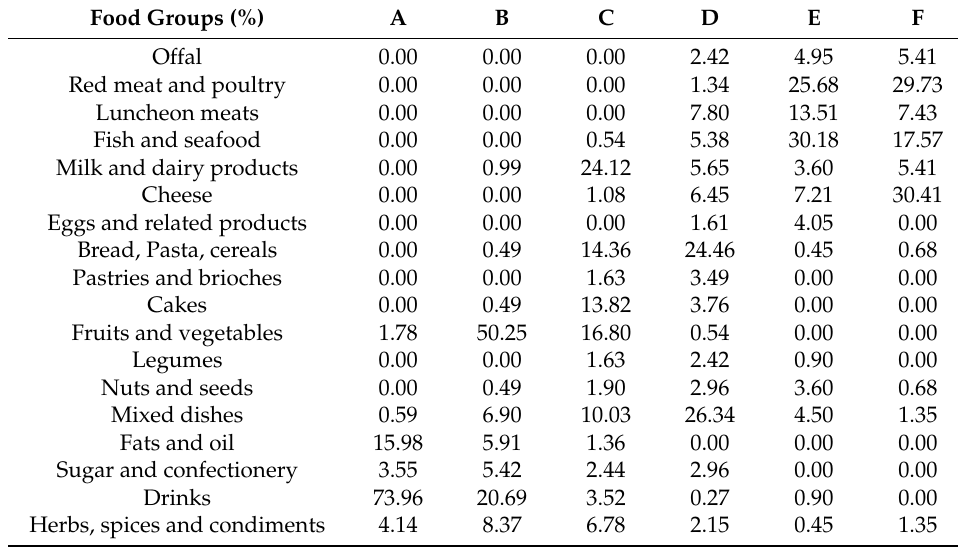
Table 2. Food groups distribution per centiles of total BCAA